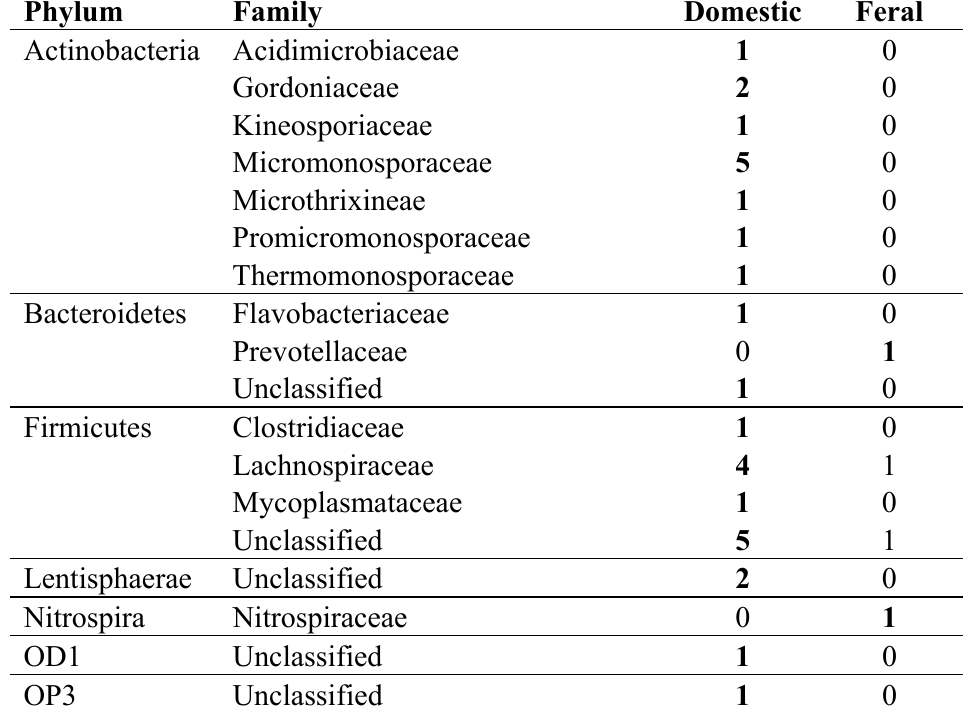
Table S3. Taxonomic distribution of 84 OTUs overrepresented in one of the goat